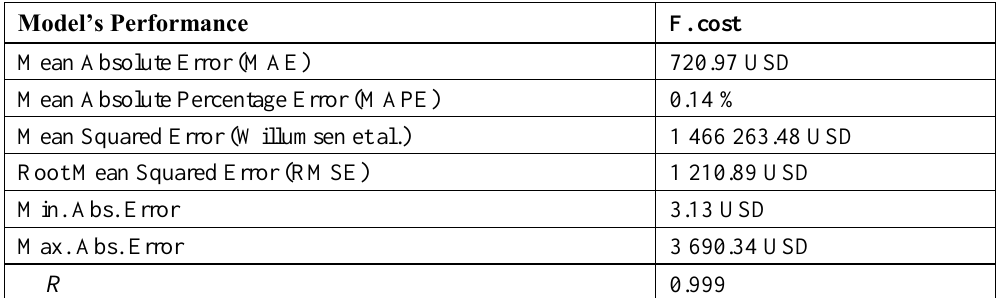
Table 6. ANN performance results (developed by the